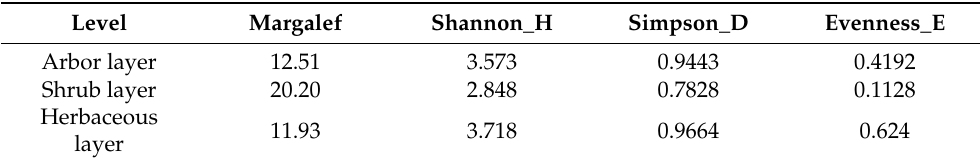
Table 4. Species diversity indexes of the samples with rare and endangered species in the Sanya River Basin, Hainan Province,